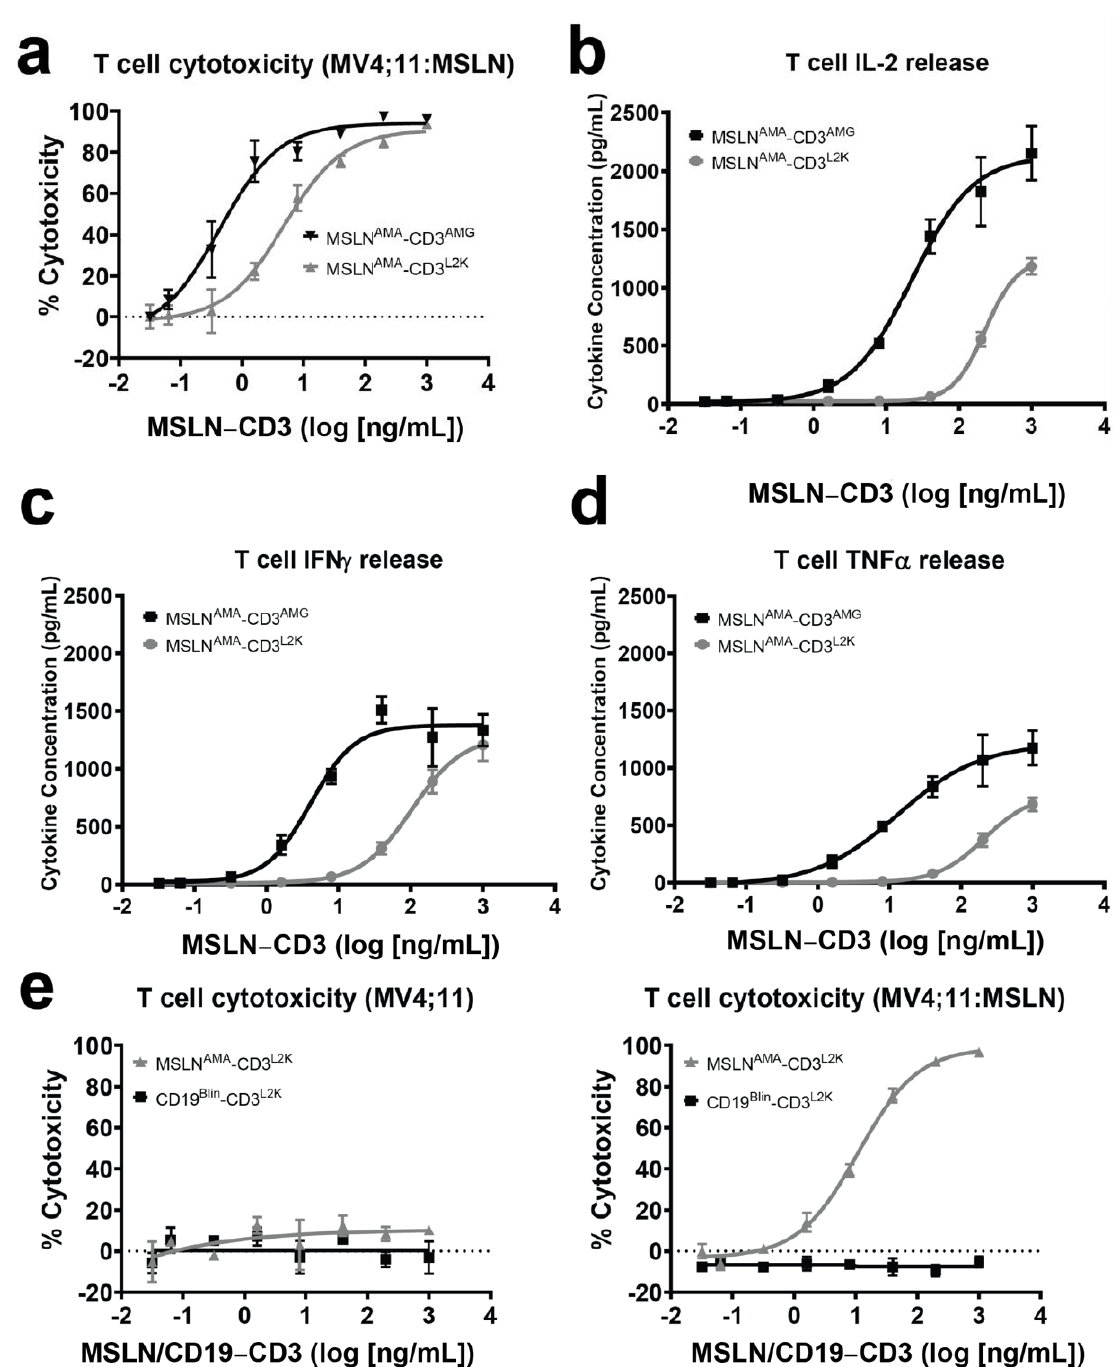
Figure 2. T cell killing and cytokine profiling of two scFv-scFv T cell engagers. ( a ) Representative T cell-mediated cytotoxicity for each of the BsAbs purified in Supplementary Figure S1. Each curve represents one BsAb at multiple concentrations (pg/mL) with three technical replicates. Data are shown as means ± SD. ( b – d ) Analysis of T cell cytokine secretion after 24 h for IL-2, IFN γ and TNF α as a function of BsAb concentration. Each curve represents cytokine quantitation at multiple BsAb concentrations (pg/mL) with technical replicates. Data are shown as means ± SD. ( e ) Representative T cell-mediated cytotoxicity for MSLN-specific BsAb and a control BsAb in MV4;11 (left) and MV4;11:MSLN cells (right). Data from three technical replicates are plotted as means ± SD.